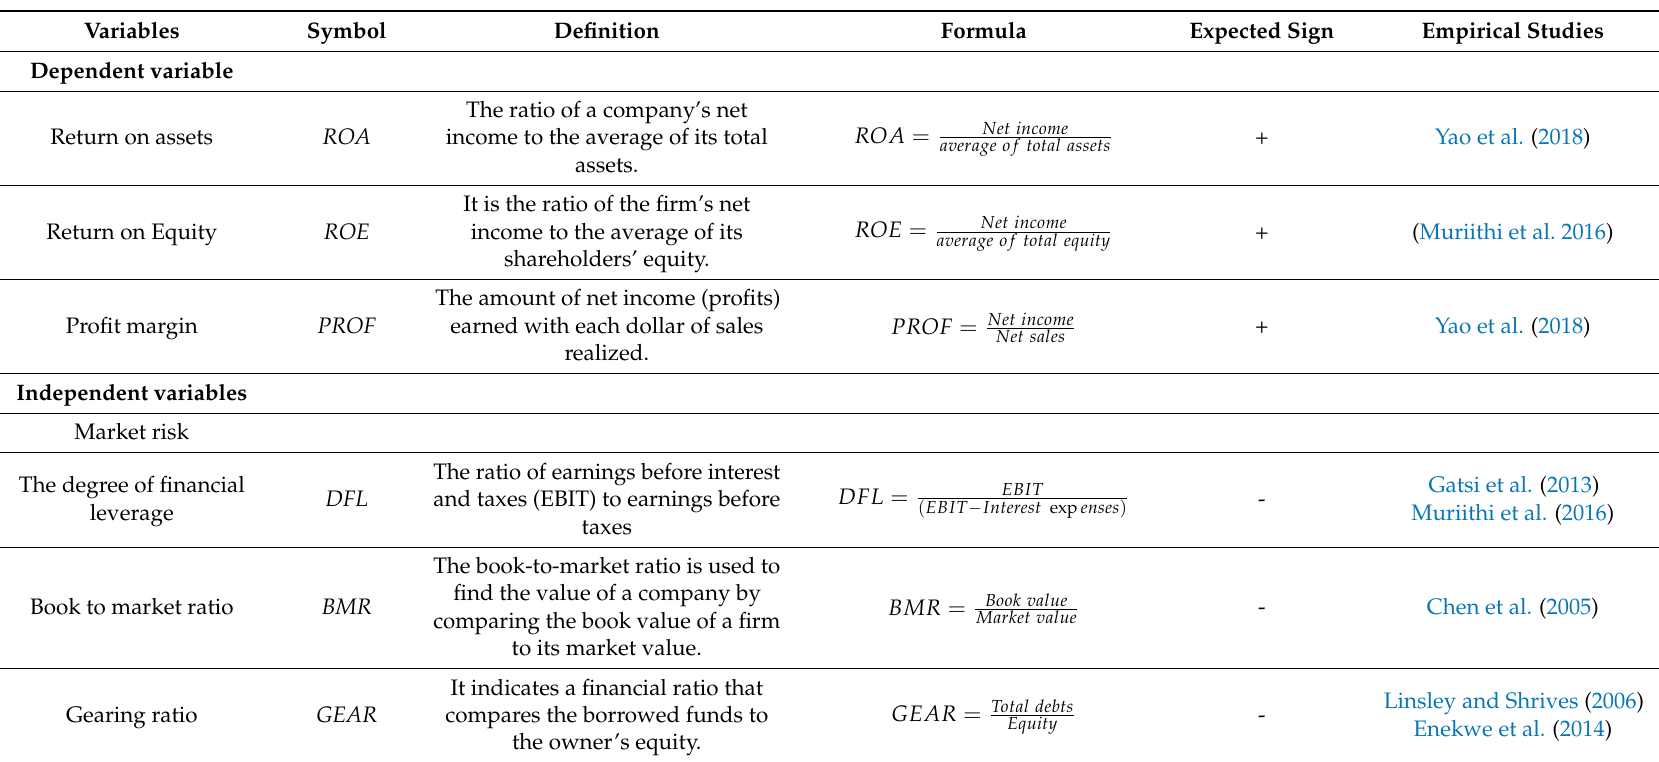
Table A1. Description of